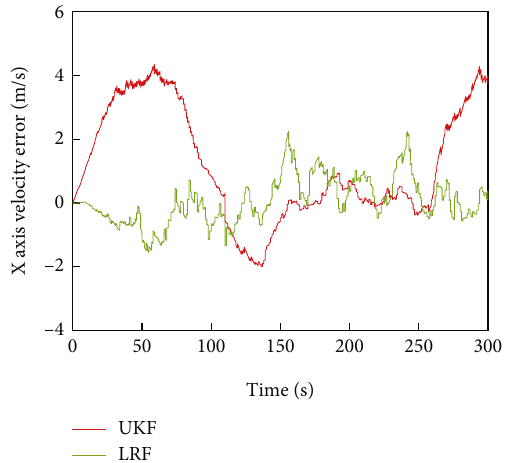
Figure 12: X -axis velocity error contrast curves